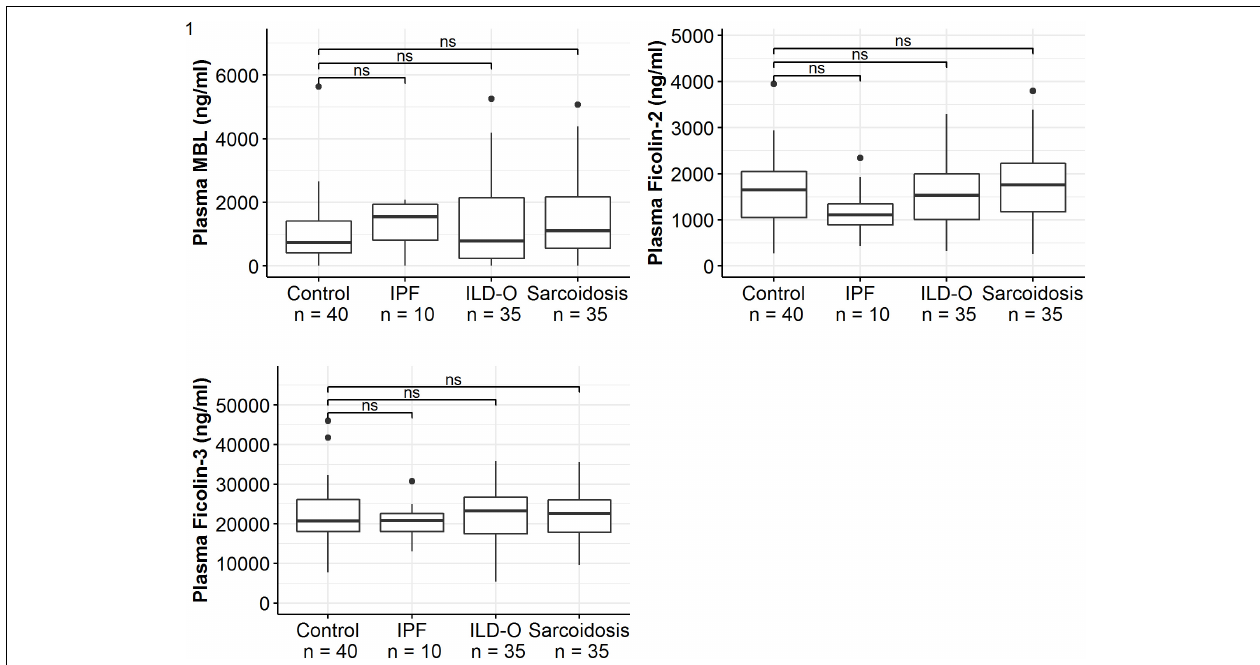
FIGURE 1 | Mannose-binding lectin, ficolin-2 and ficolin-3 plasma concentrations of idiopathic pulmonary fibrosis (IPF), non-IPF patients other than sarcoidosis (ILD-O), sarcoidosis and control patients. Horizontal bars annotated with “ns” denote non-significant comparisons (Mann–Whitney U